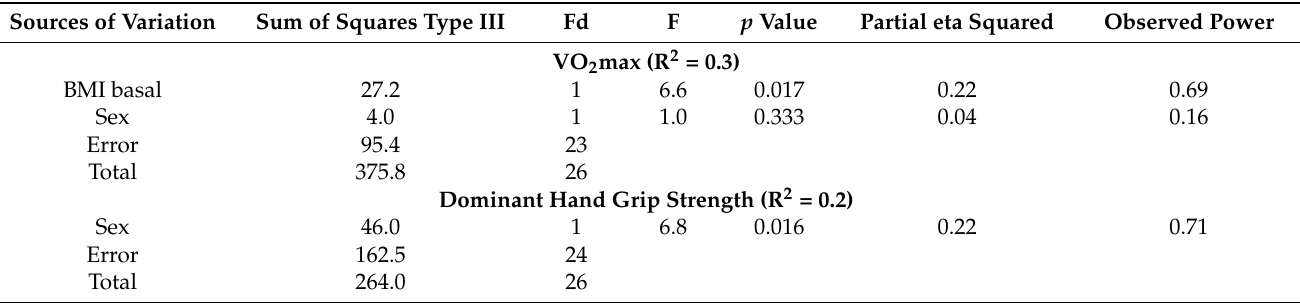
Table 3. The maximal oxygen intake and dominant handgrip strength explained by sex and BMI. Changes after exercise.